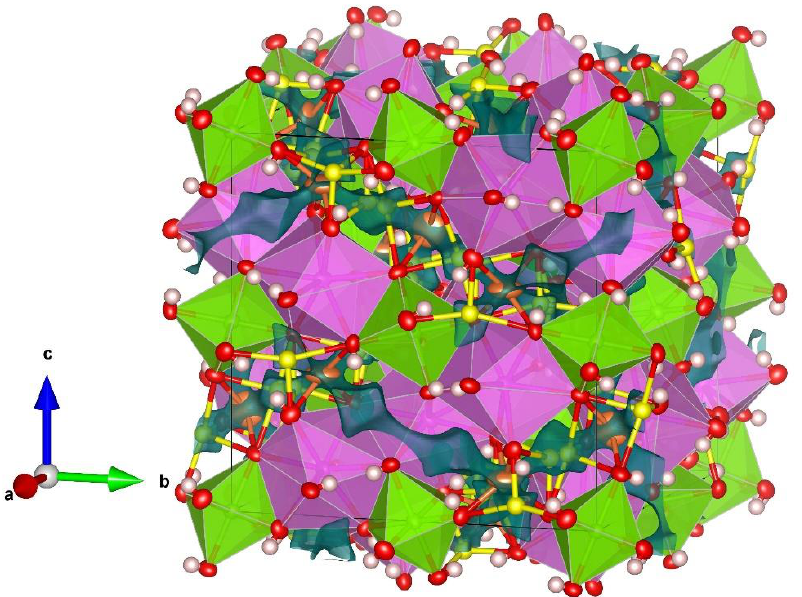
Figure 5. Crystal structure of Al10-LLZO, aged for 936 days, with the space group 𝐼𝑎3̅𝑑 , in a polyhedral representation. LaO 8 sites appear in pink, ZrO 6 octahedra is yellowish-green. The Li(1) (orange) and Li(2) sites (yellow) are shown as anisotropic/isotropic atomic displacement ellipsoids only to highlight the three-dimensional network for Li-ion conduction. Light pink circles represent tentative H positions. The 3-dimensional network for possible Li-diffusion is shown as a bond valence energy landscape map at a level of 1.0 eV above the minimum (blue-green contours). Both Li-sites are only partly filled. This is discernible in the first refinement cycle.